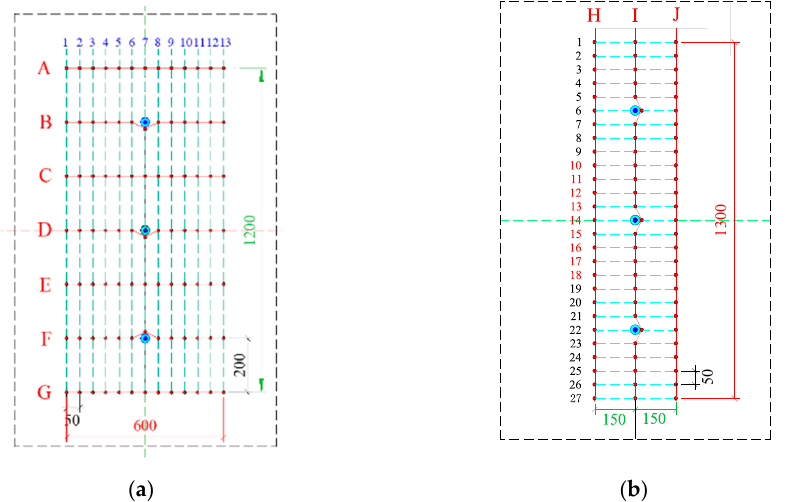
Figure 2. Schematic diagram of temperature measuring point layout. ( a ). Main test plane measuring point (mm); ( b ). Auxiliary test plane measuring points (mm).